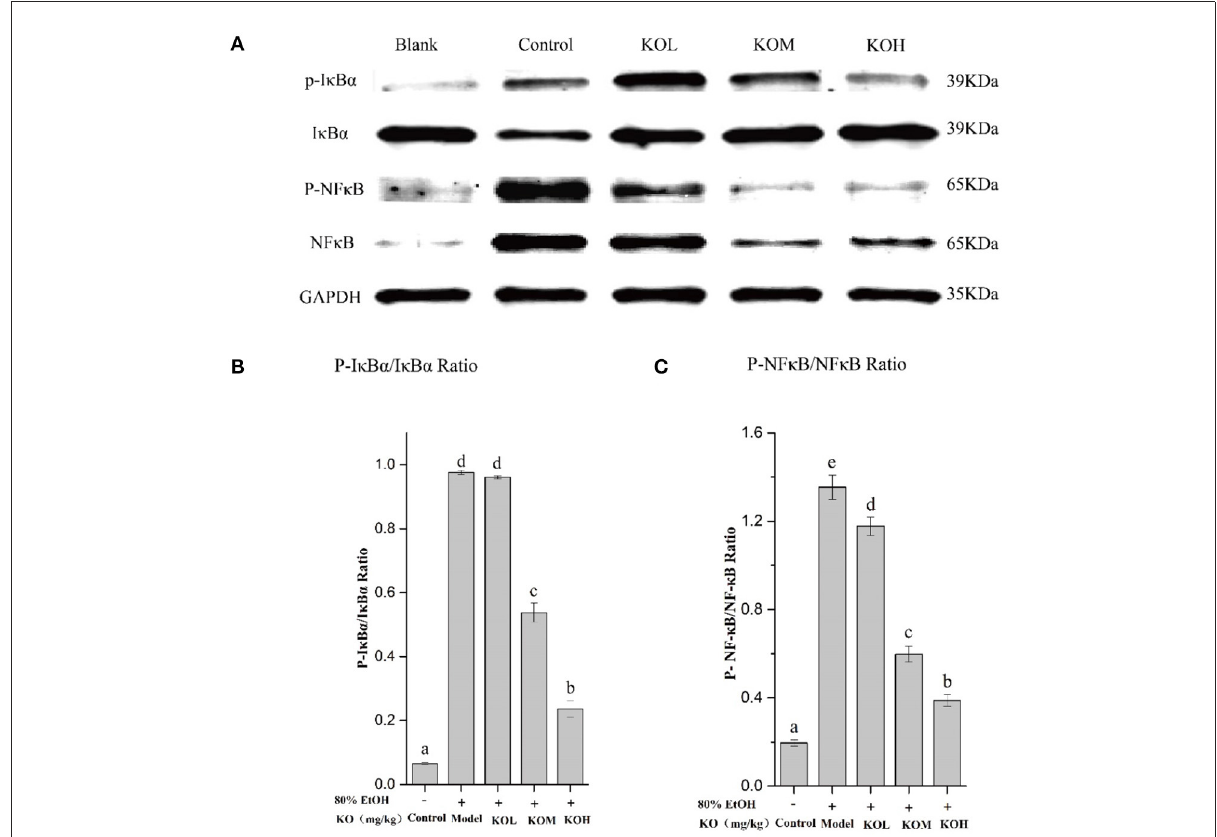
FIGURE5 KO inhibits inflammation in the expression levels of I κ B α and NF- κ B in gastric tissues. (A) Protein levels of p-I κ B α , I κ B α , P-NF- κ B, and NF- κ B in colon were investigated using western blot analysis; (B) relative expression of P-I κ B α /I κ B α ; (C) relative expression of P-NF- κ B/NF- κ B indicate that KO can significantly reduce inflammation by inhibiting the phosphorylation of I κ B α and NF- κ B. Different letter values (n = 6; mean ± SEM) indicate statistically significant differences from the same column model group ( p < 0.05 ). KOL, krill oil of 100 mg/kg; KOM, krill oil of 200 mg/kg; KOH, krill oil of 500